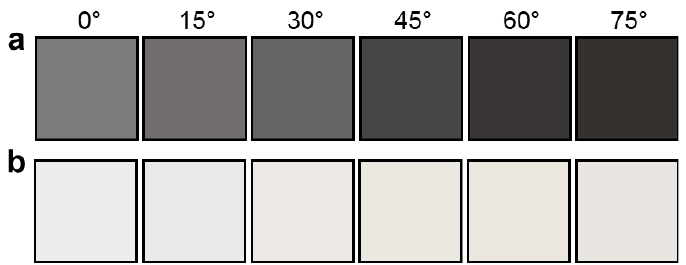
Figure 5. The images of ( a ) the fabricated GHLC cell and ( b ) regular glass at the incident angles of 0°, +15°, +30°, +45°, +60°, and +75°.